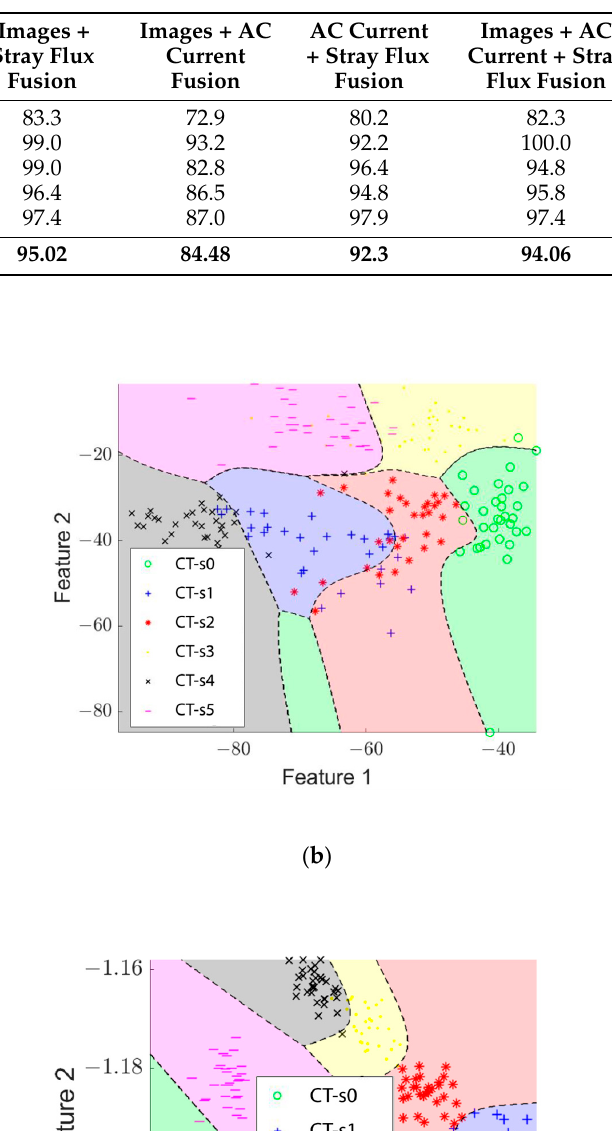
Table 6. Effectiveness results for the classification of tool wear with the use of the FFNN for the cutting speed tests.